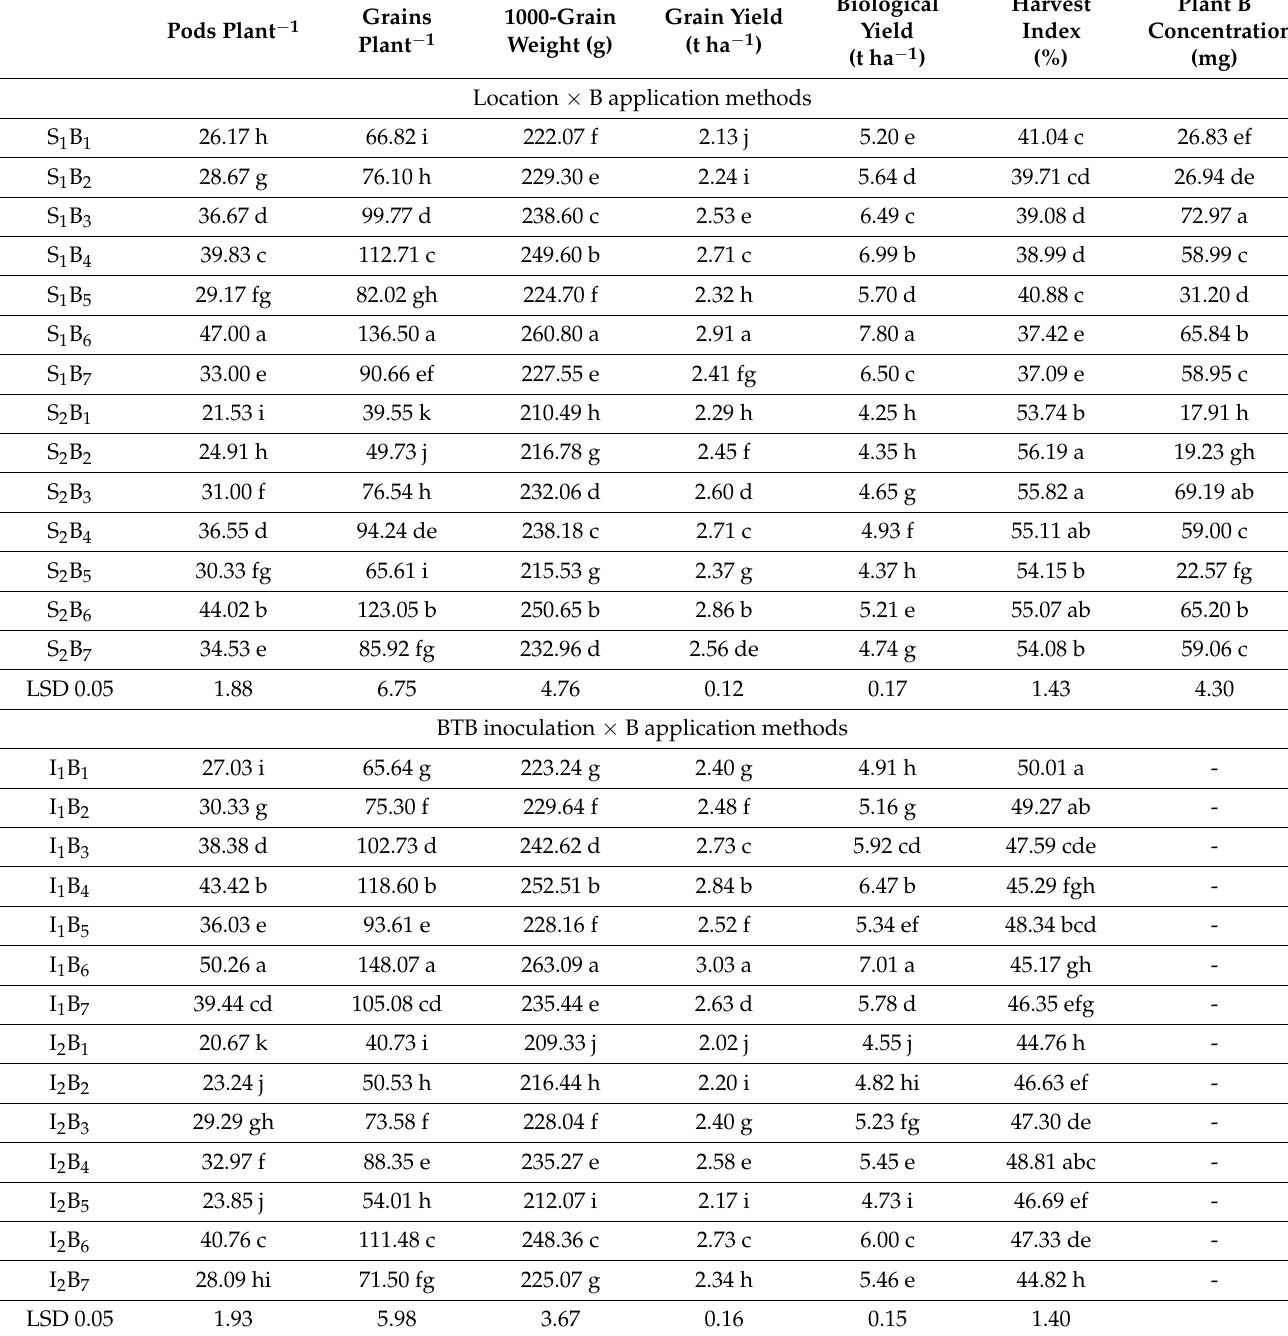
Table 5. The impact of location and BTB inoculation interactions with boron application methods on growth and yield-related traits of desi